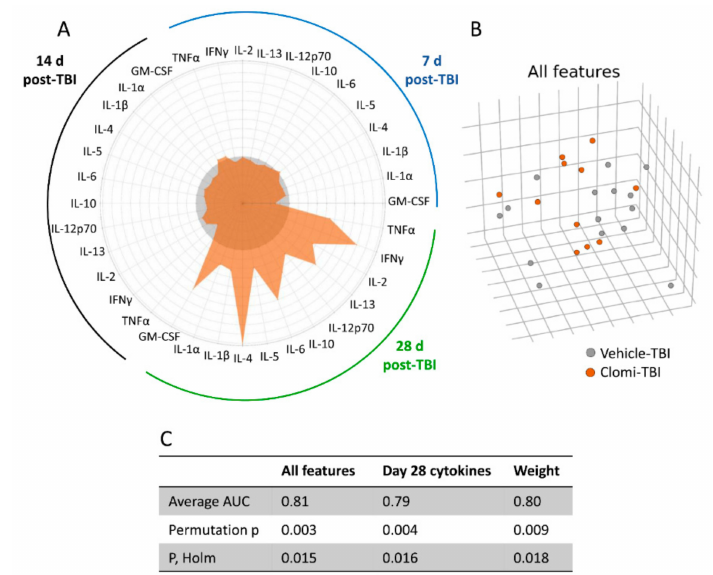
Figure 4. E ff ect of clomipramine on plasma cytokines and machine learning analysis. ( A ) A radar plot showing the levels of plasma cytokines in clomipramine (Clomi)-treated (orange, n = 11) and vehicle-treated (grey, n = 15) rats with lateral fluid-percussion-induced traumatic brain injury (TBI) at 7 days, 14 days, 28 days post-TBI. Mean concentrations were obtained from the linear mixed e ff ect model (Table S3). Note that machine learning di ff erentiated Vehicle-TBI and Clomi-TBI rats by all tested cytokines at 28 days post-TBI. ( B ) 3D dot-plots showing the di ff erentiation of Vehicle-TBI and Clomi-TBI rats in machine learning analysis by all features [area under curve (AUC) 0.81]. ( C ) Summary of machine leaning analysis of Vehicle-TBI and Clomi-TBI groups. Average AUC score from 10 cross-validation. Machine learning di ff erentiated Vehicle-TBI rats (grey) and Clomi-TBI (orange) (AUC